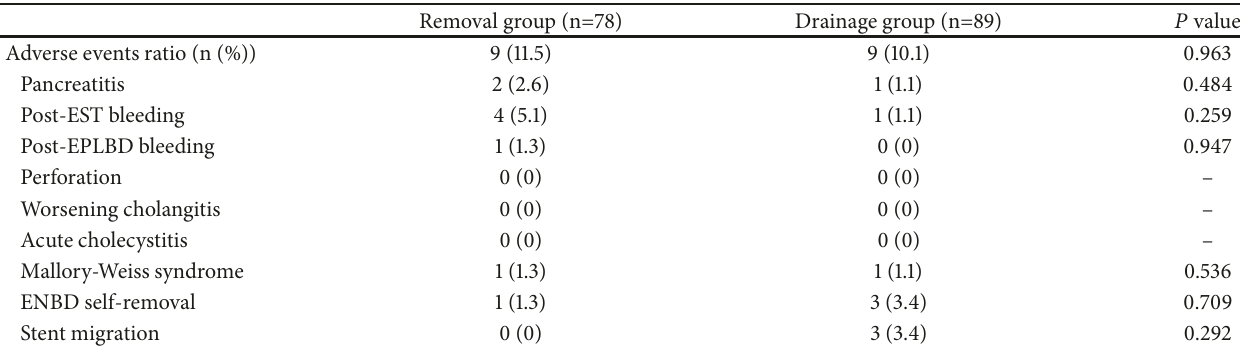
Table 4: Comparison of adverse events in early ERCP between the removal and drainage